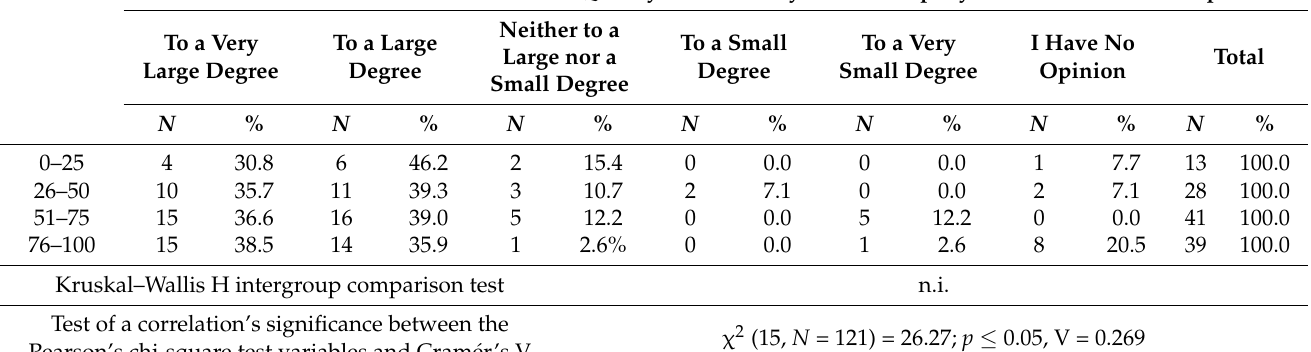
Table 11. Structural (socio-demographic) index: chi-square test of a correlation’s significance.